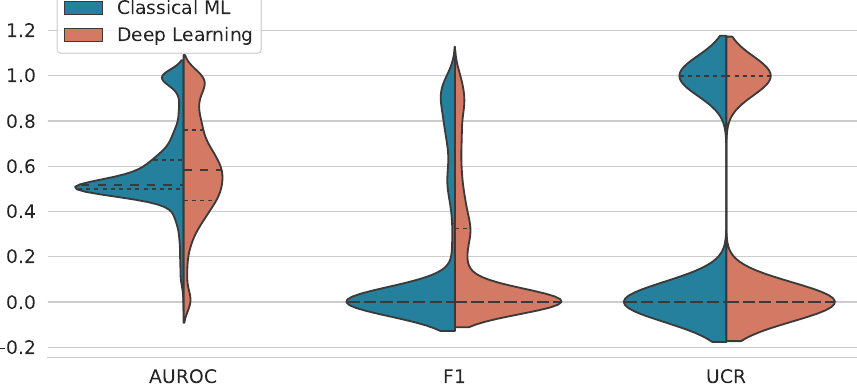
Figure 5. Distribution of results for the AUC ROC, F1 Score and UCR score aggregated by model class. The dashed lines encode the quartiles of the distributions. The area under the peaks around 1 is larger for the Classical ML methods for F1- and UCR